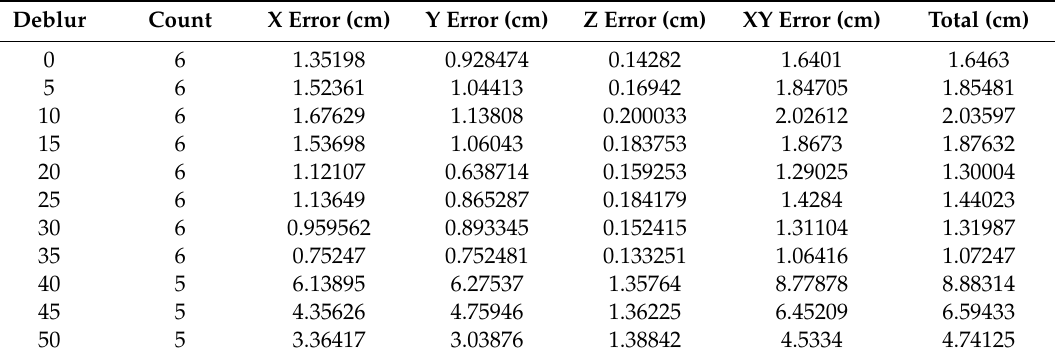
Table 8. Control points RMSE (X—Easting, Y—Northing, Z—Altitude).